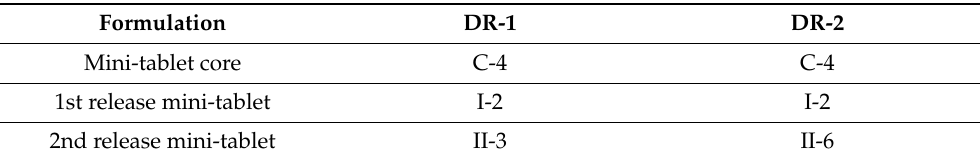
Table 4. Combination of EMP-loaded DR polycaps containing 10 of 1st release mini-tablet and 10 of 2nd release mini-tablet. Formulation DR-1 DR-2 Mini-tablet